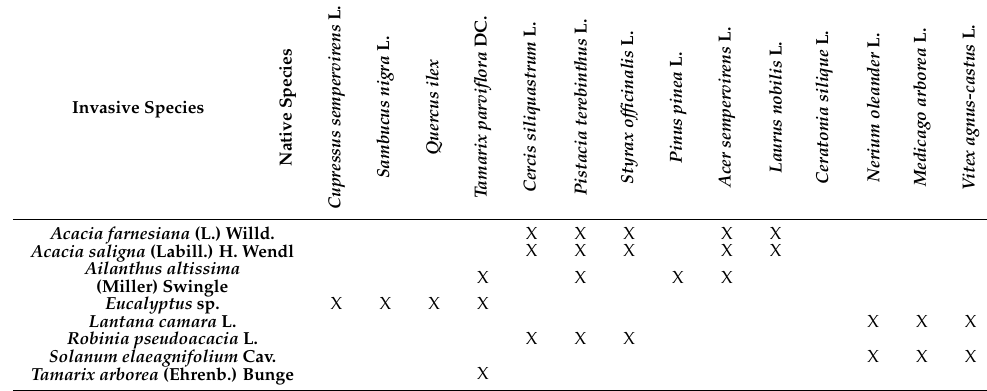
Table 6. Proposals for replacement of some invasive plants with native Mediterranean plants with similar functions. Invasive plants listed in [195] and [203] for Crete and Greece,